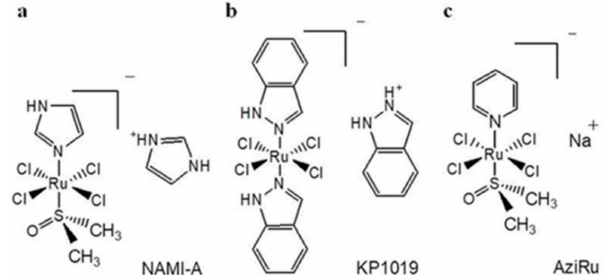
Figure 1. Molecular structures of the Ru(III) complexes NAMI-A ( a ), KP1019 ( b ) and AziRu ( c